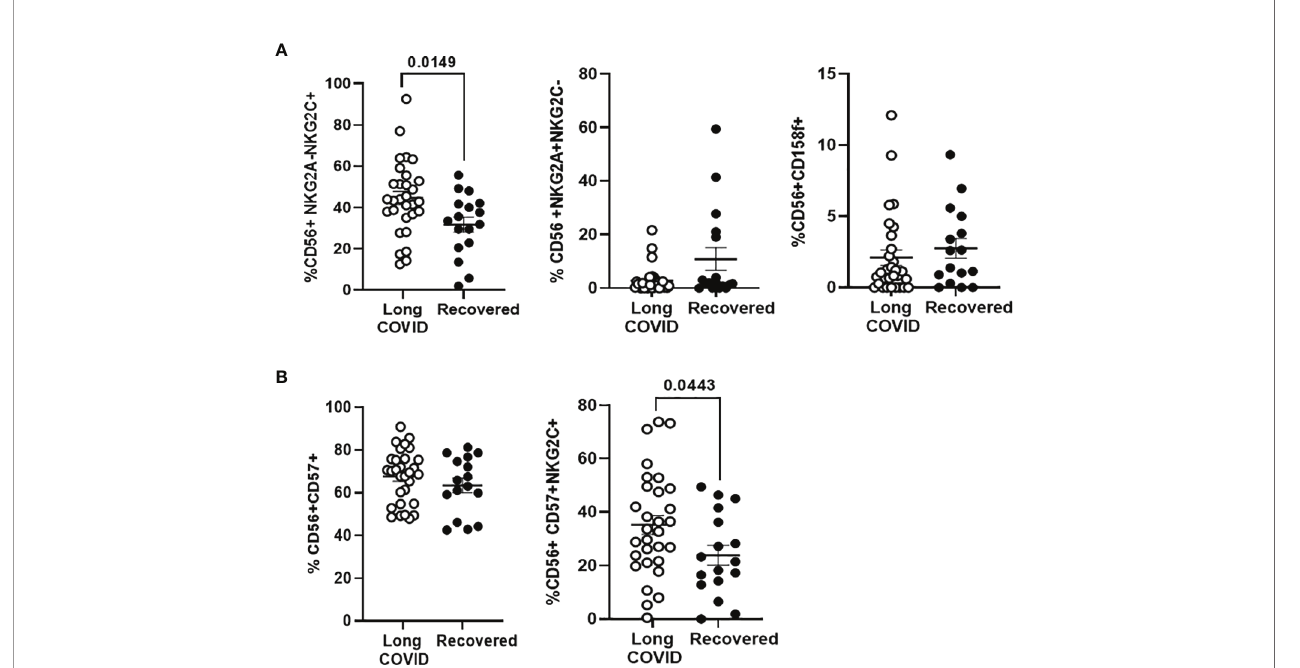
FIGURE 4 | Analysis of the expression of NK cell markers in PBMCs from the Long-COVID and Recovered groups. (A) Analysis by fl ow cytometry of the expression of the activating receptor NKG2C and the inhibitory receptors NKG2A and KIR2DL5/CD158f on the surface of total CD56 + cells. (B) Analysis by fl ow cytometry of the expression of the activating receptor NKG2C and the memory marker CD57 on the surface of total CD56 + cells. Each dot in the graphs corresponds to one sample, and lines represent mean ± SEM. Statistical signi fi cance was calculated using non-parametric Mann – Whitney test. PBMCs, peripheral blood mononuclear